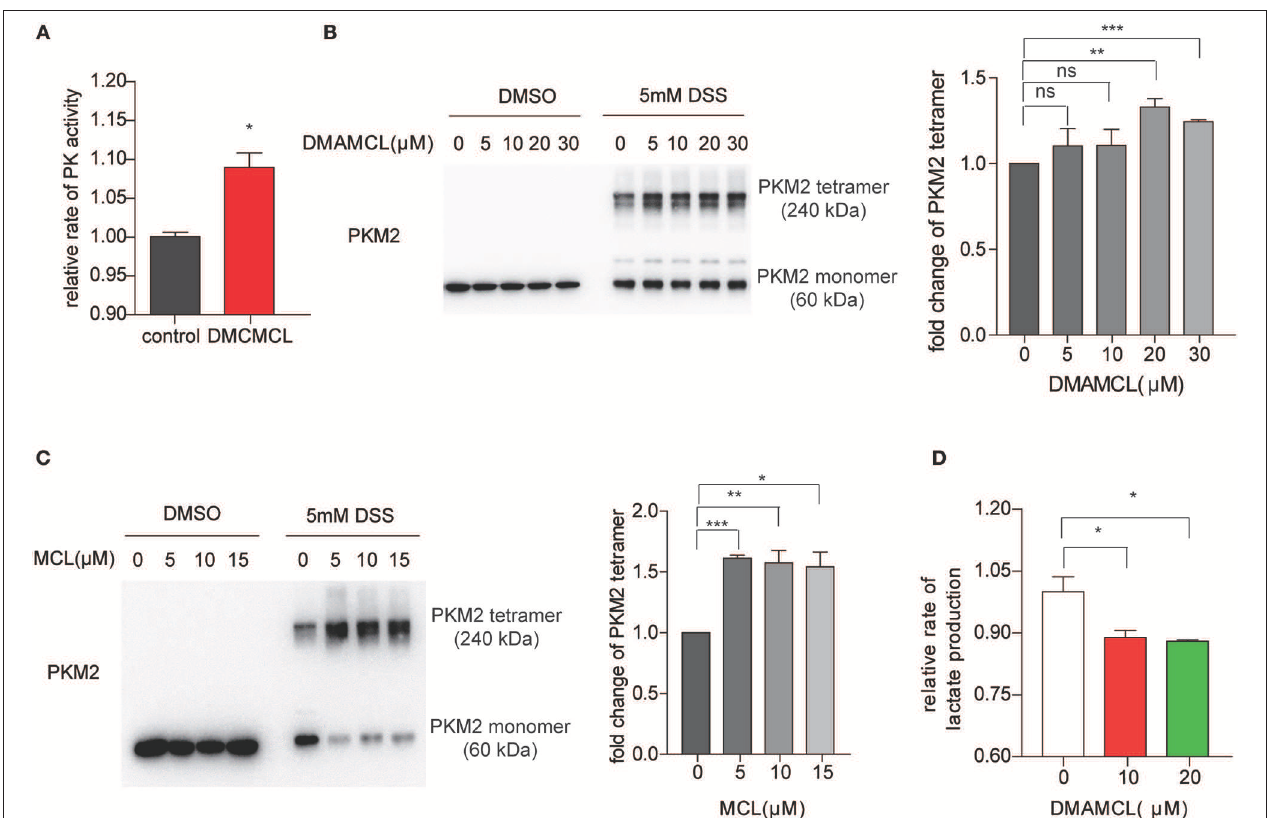
FIGURE 3 | DMAMCL and MCL increase the pyruvate kinase activity by promoting the formation of tetrameric PKM2. (A) U118MG cells were incubated with DMAMCL for 24h, and then the cells were lysed and determined by PK activity assay. (B,C) U118MG cells were treated with DMAMCL or MCL for 24h at indicated concentrations, and then the cell-lysates were crosslinked with DSS. Western blot confirmed the oligomerization of PKM2, and the fold change of PKM2 tetramer was quantified. (D) U118MG cells were treated with DMAMCL for 24h, and the lactate was determined in the DMAMCL-treated medium and control medium. Error bars, mean ± s.e.m., n = 3 biological replicates. * P < 0.05, ** P < 0.01, *** P < 0.001, ns, no